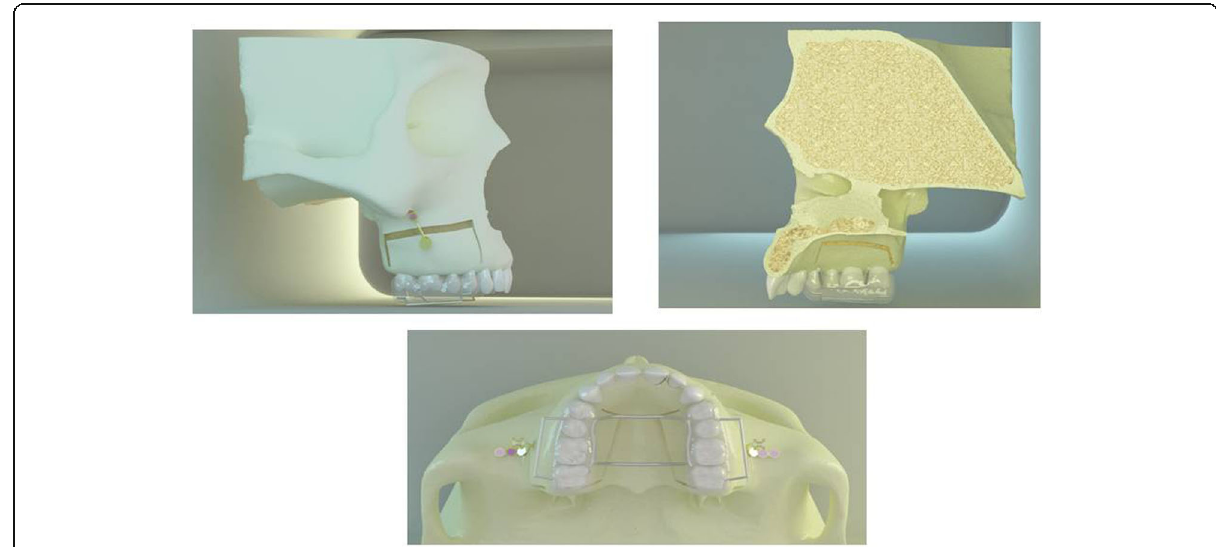
Fig. 2 Models presenting buccal and palatal subapical corticotomies